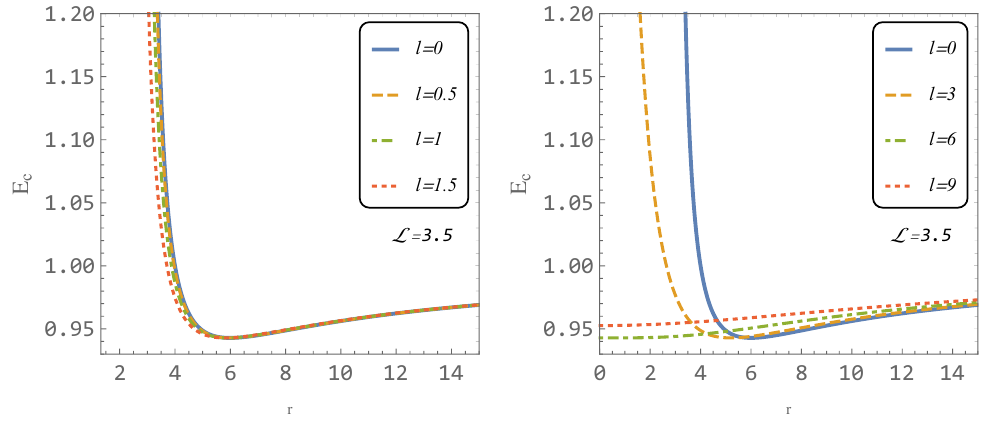
Figure 2. The radial profiles of the specific energy E of test particle for characteristic values of the parameter l and M = 1. Values of l < 2 M giving regular black holes are on the left panel, while values of l > 2 M giving wormholes (except l = 0 giving for comparison the Schwarzschild black hole) are on the right